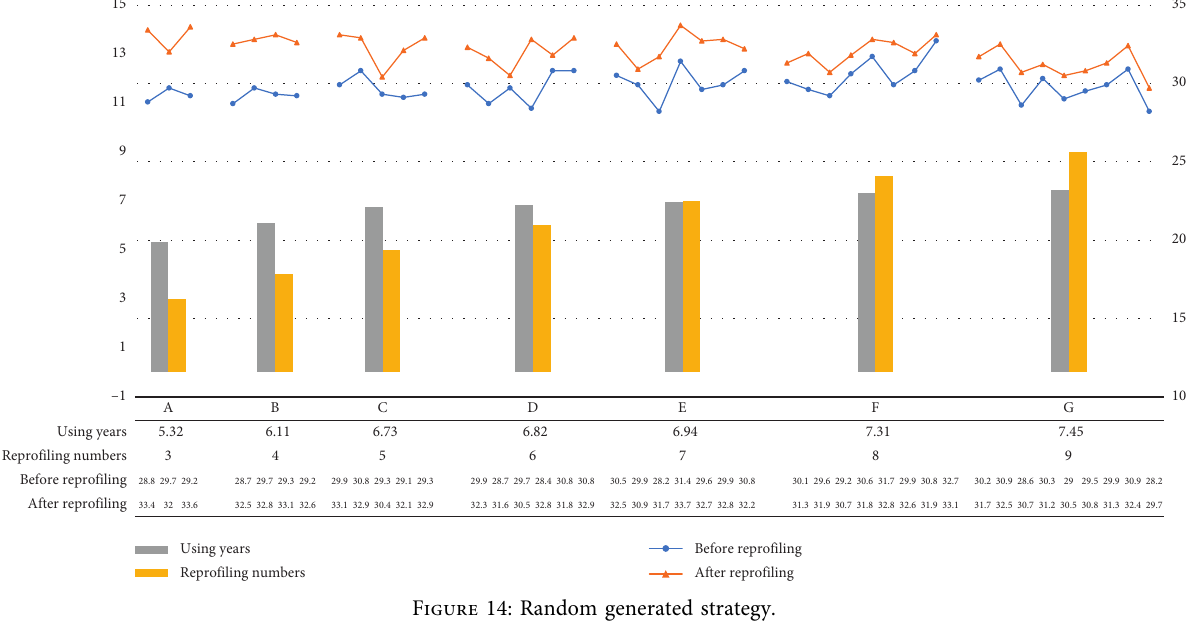
Figure 14: Random generated strategy.